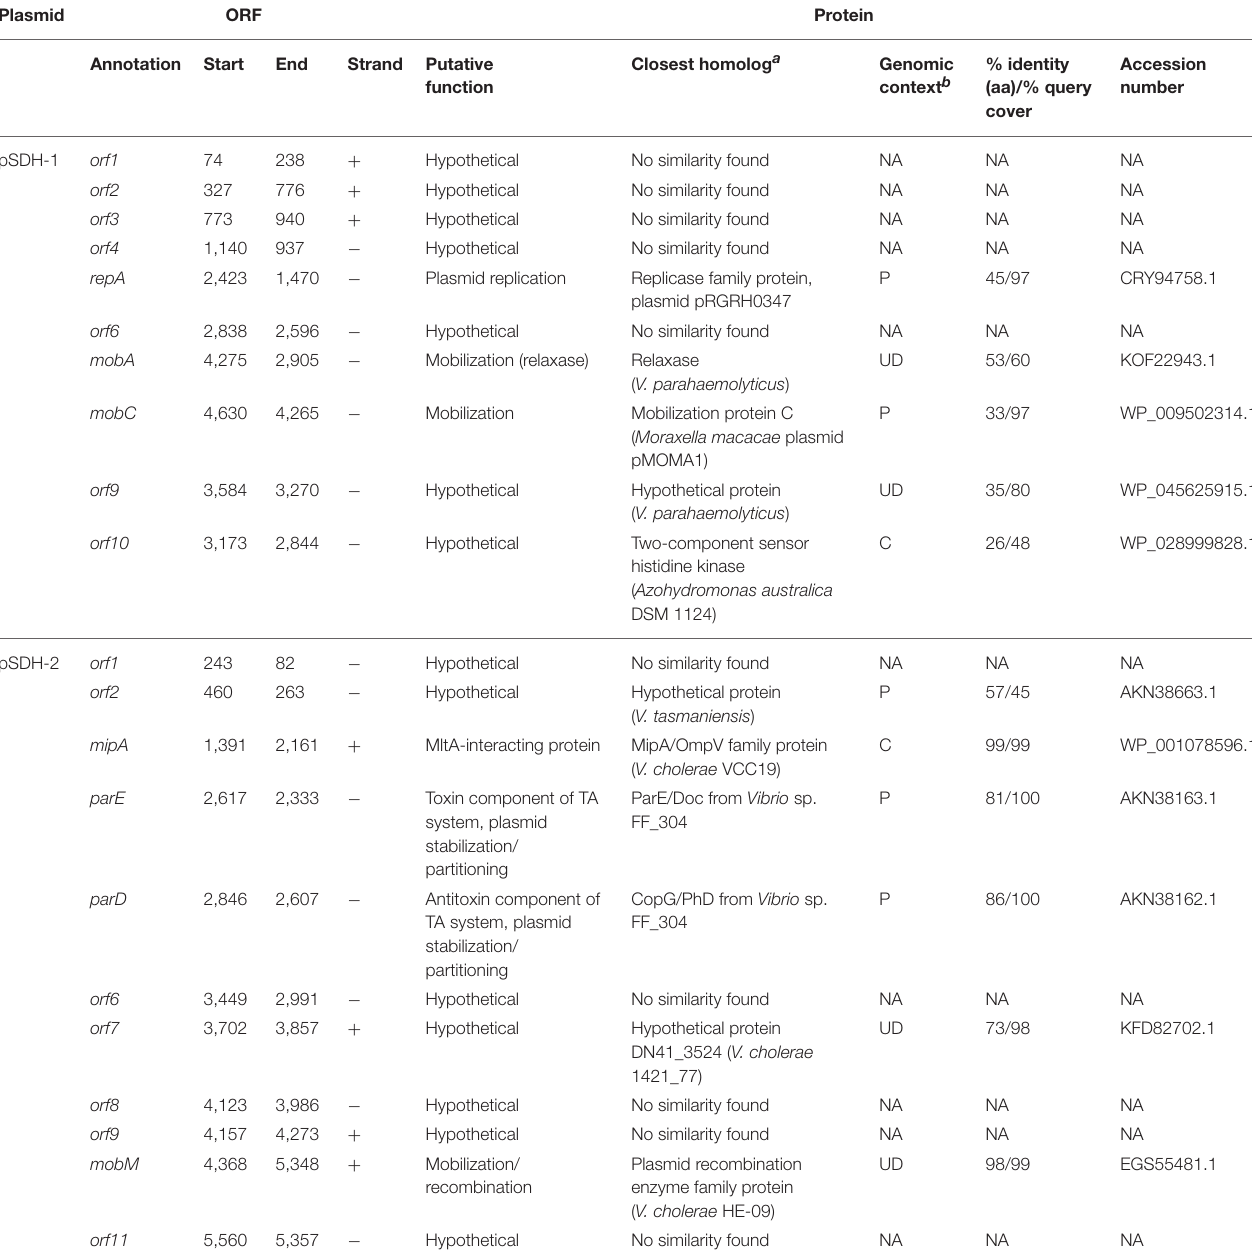
TABLE 1 | ORF content of pSDH-1 and pSDH-2. Plasmid ORF Protein Annotation